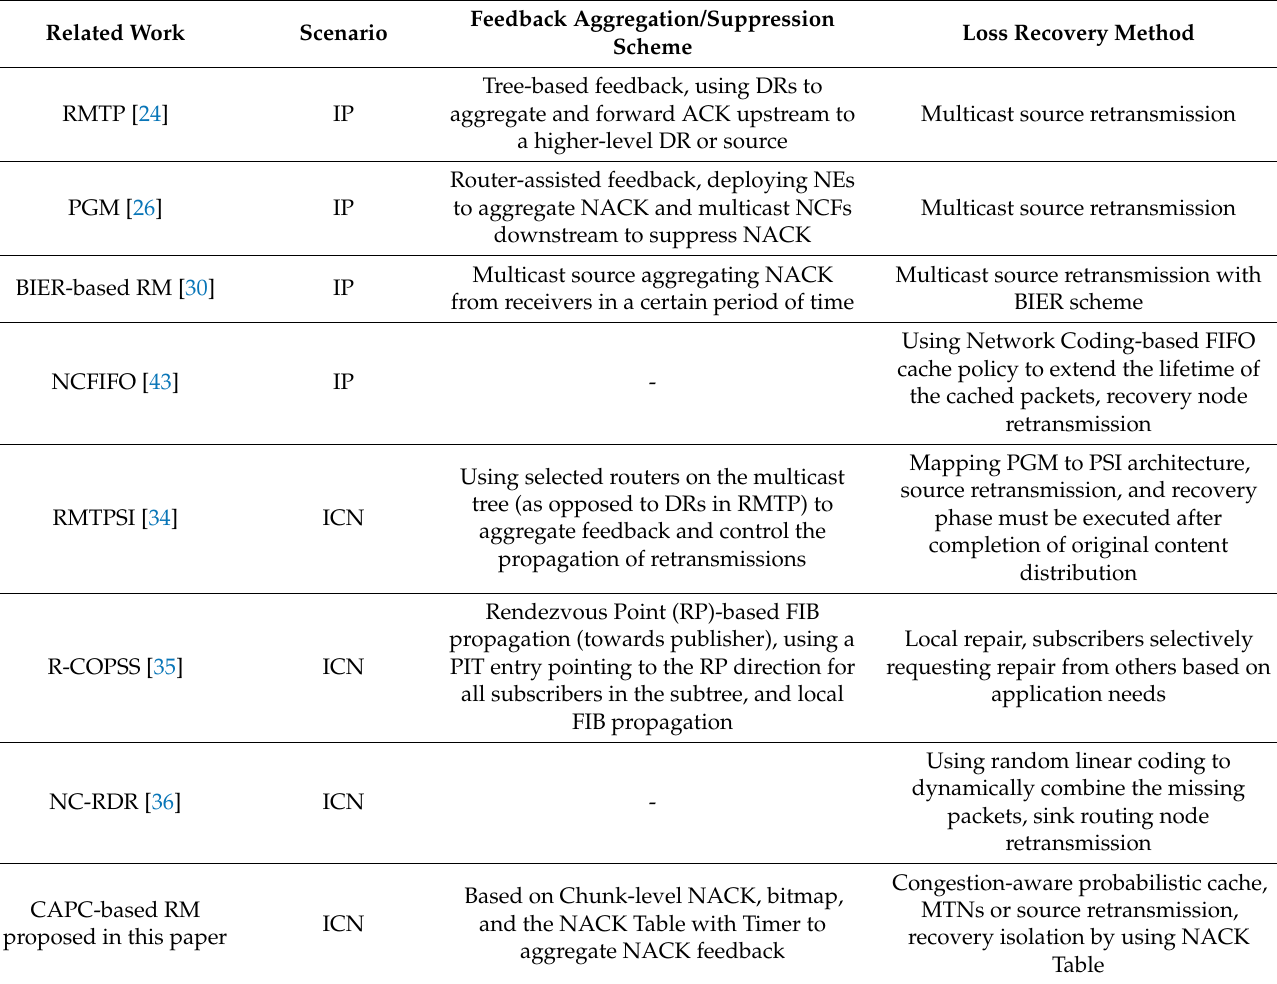
Table 1. Summary of the reliable multicast approaches in the